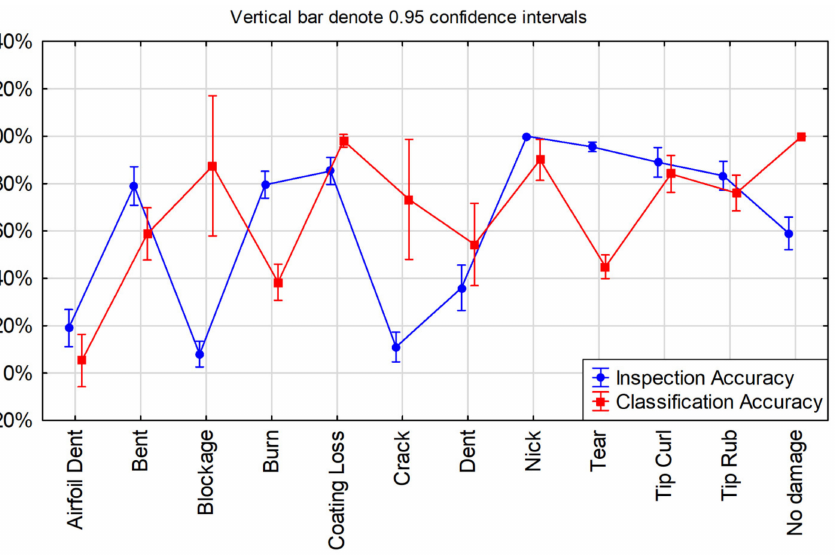
Figure 9. Mean inspection accuracy and defect classification accuracy for each defect